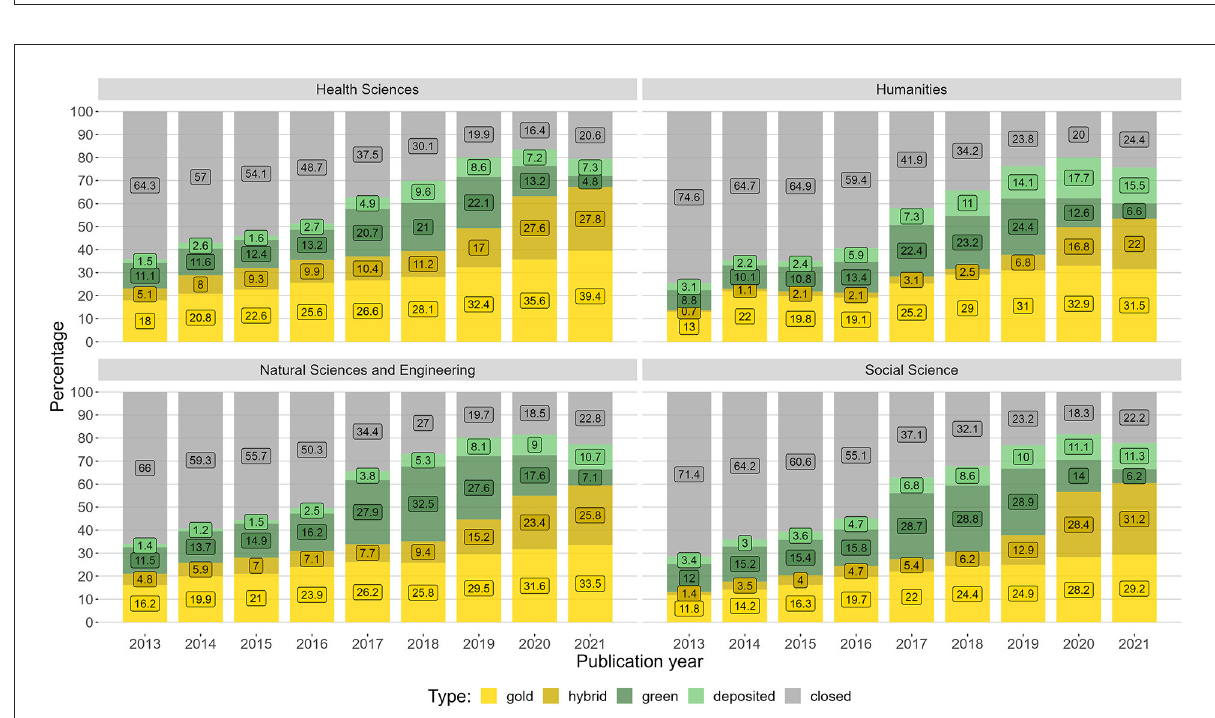
publication. In addition, deposited articles (shown in light green in Figure 2) do not always reach the status of green open access. Even though presumably most embargo periods have